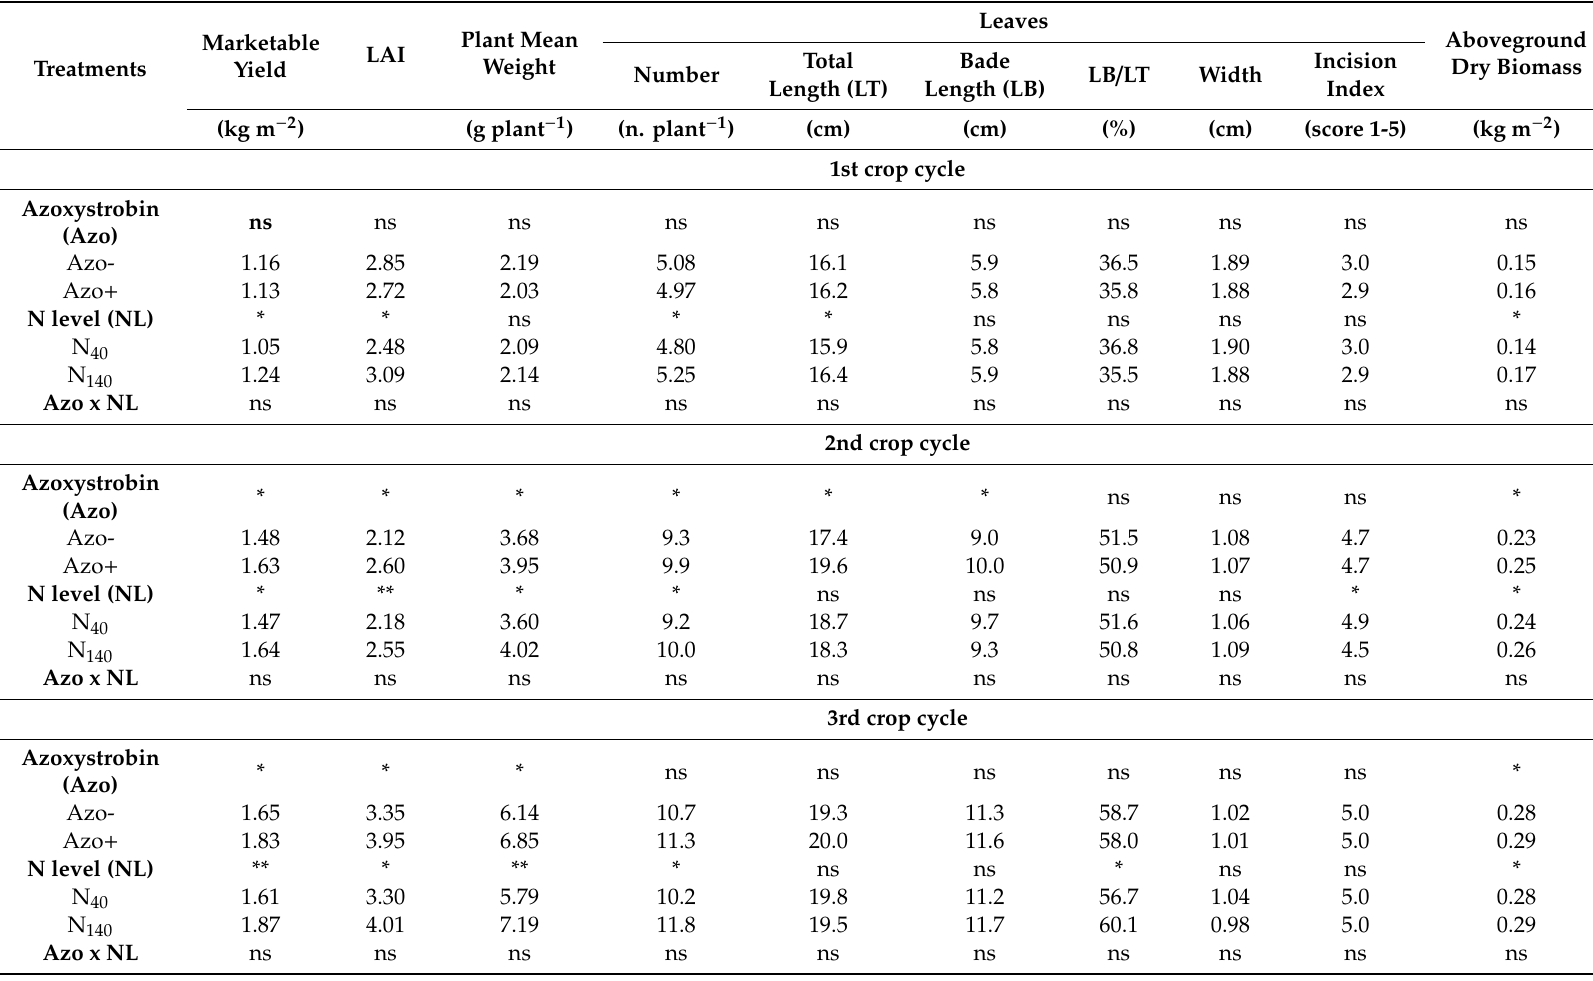
Table 1. E ff ects of the Azoxystrobin (Azo) application and N level (NL) on the yield and some morphological traits of wild rocket in the four crop cycles. Azo − = control without Azoxystrobin, Azo + = with Azoxystrobin; N 40 = 40 kg ha − 1 of N, N 140 = 140 kg ha − 1 of N.